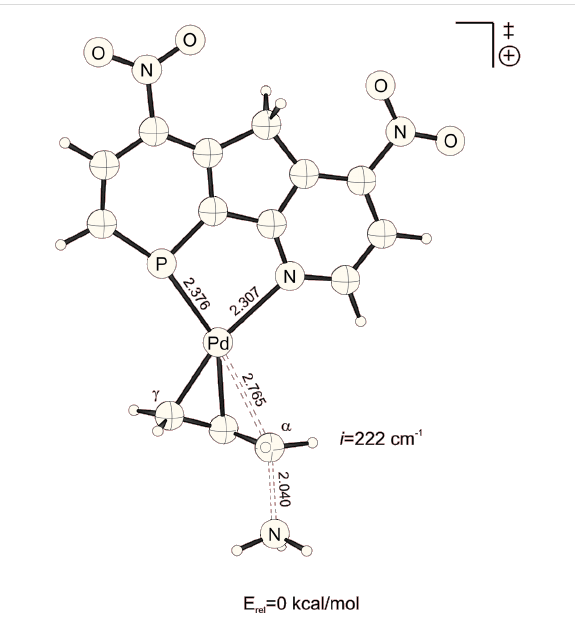
Figure 1: Transition structure for the energetically favored trans to phosphorus addition of ammonia at the Pd-η 3 -allylic intermediate (B3LYP/6-31G* (C, H, N, P, O), /SDD (Pd)). Bond distances are given in Å.